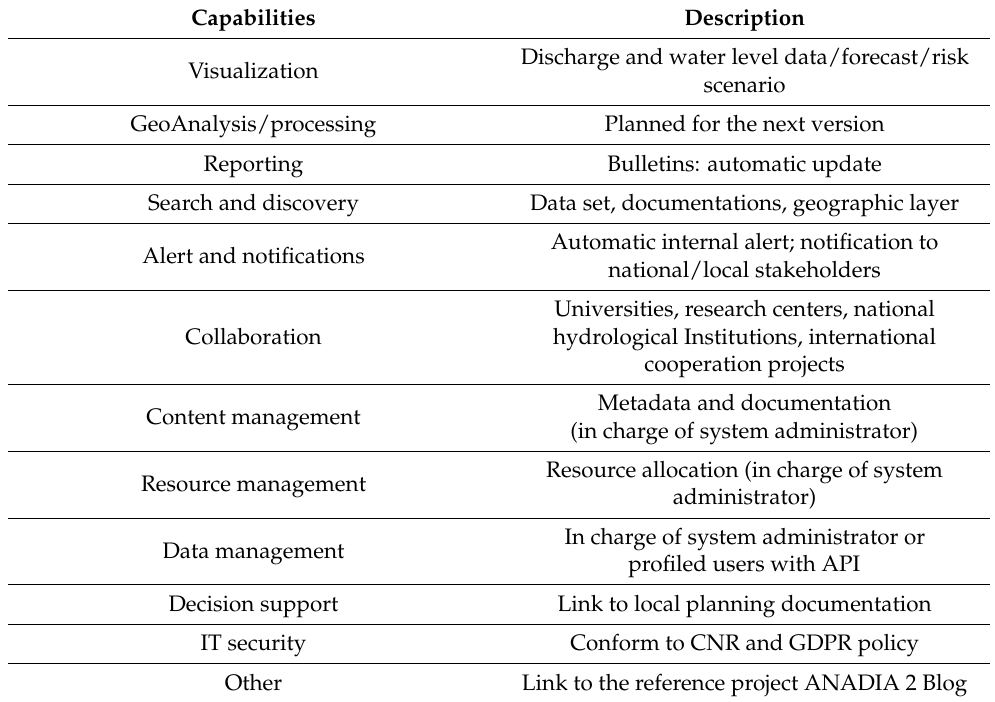
Table 4. SLAPIS core